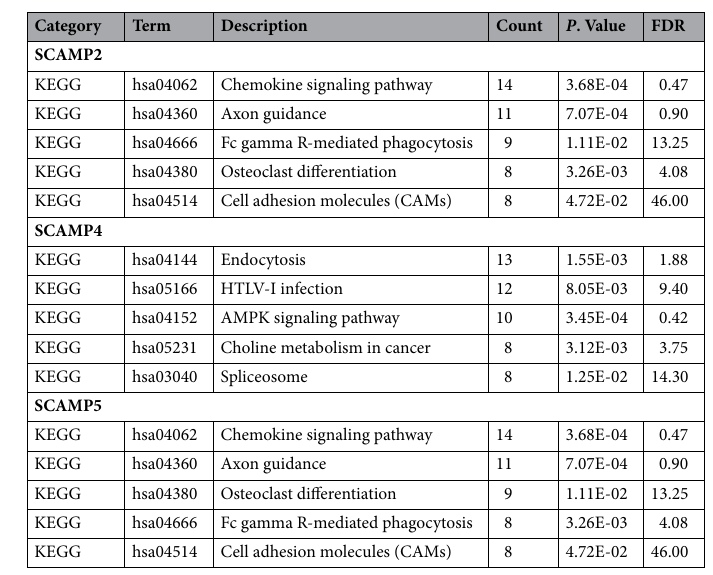
Table 4. The top 5 KEGG function enrichment analysis of SCAMPs and co-expressed genes in AML